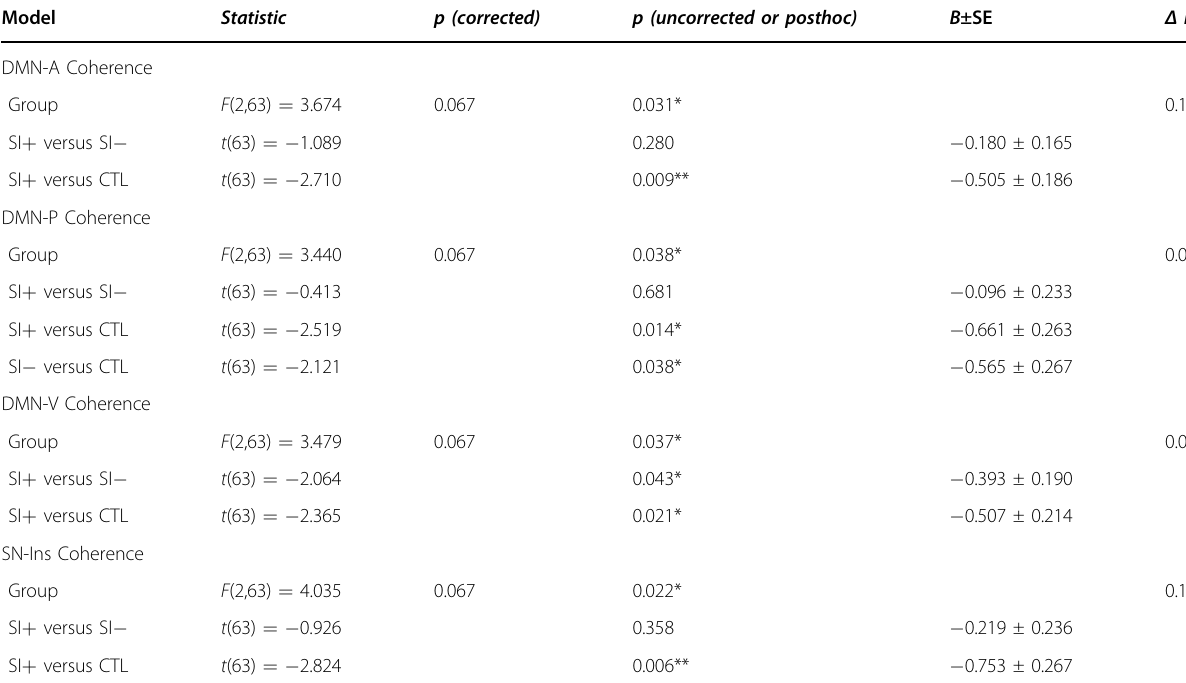
Table 2 Results of statistical models with a signi fi cant overall effect of group (SI + , SI − , CTL) on network coherence with planned linear contrast tests (SI + versus SI − and SI + versus